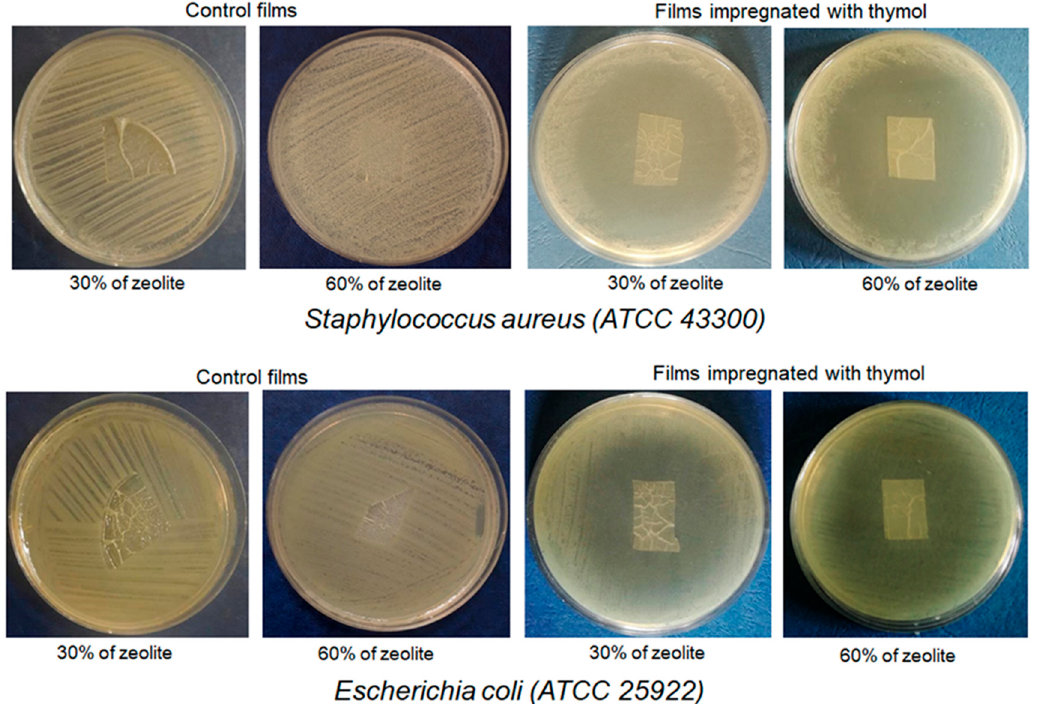
Figure 7. Antibacterial activity of the control and SCZT films with 24% of thymol.